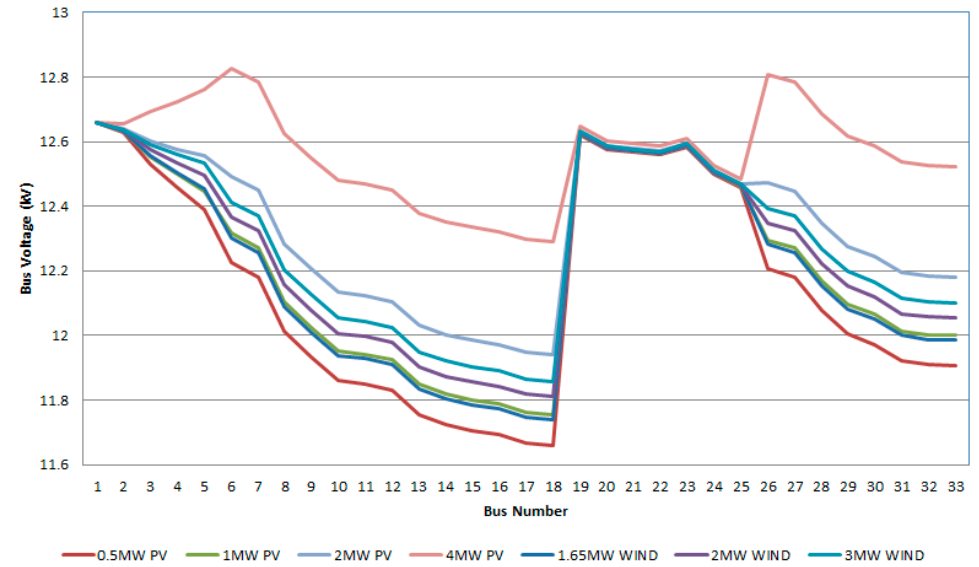
Figure 7. Voltage profiles of network buses when different DG unit sizes have been connected at bus 6.